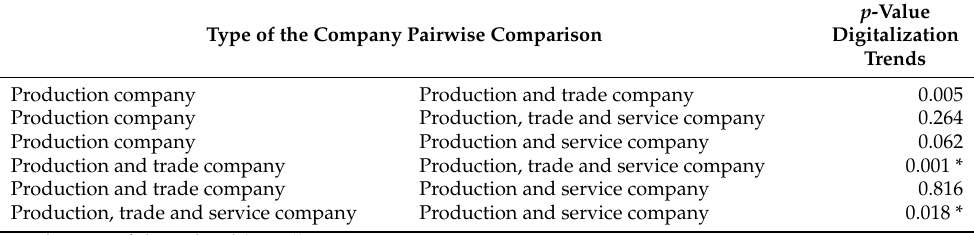
Table 9. Pairwise comparison using Mood’s median test: digitalization trends vs. type of the